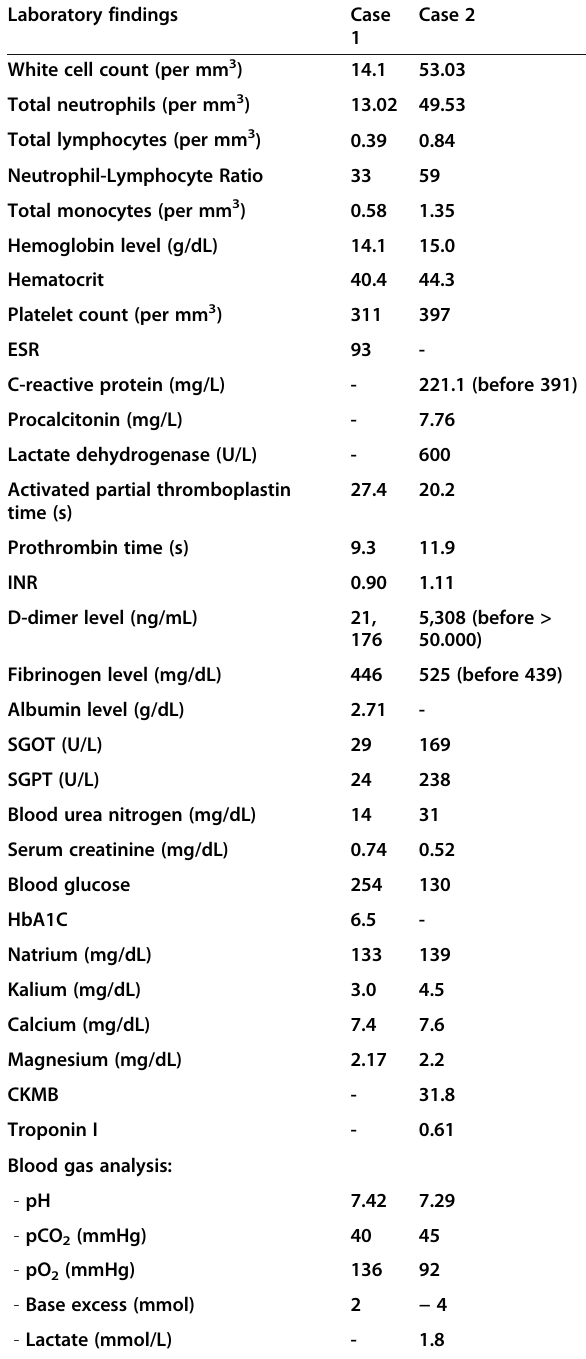
Table 1 Summary of laboratory findings at admission Laboratory